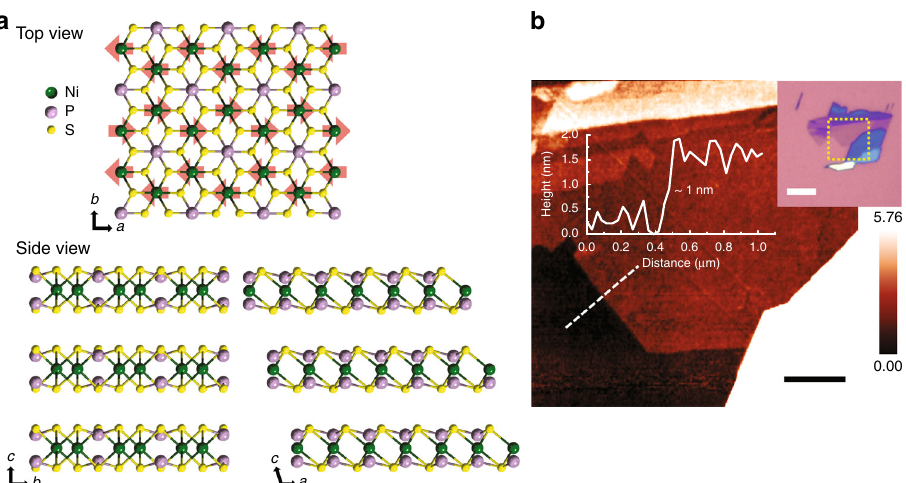
Fig. 1 Magnetic van der Waals material NiPS 3 . a Crystal structure of NiPS 3 . Red arrows indicate the spin orientations of Ni atoms below Néel temperature ( T N ). b Atomic force microscope image and thickness line pro fi le of monolayer NiPS 3 . Optical image of the sample is shown in inset. The black and white scale bars are 1 and 5 µ m, respectively